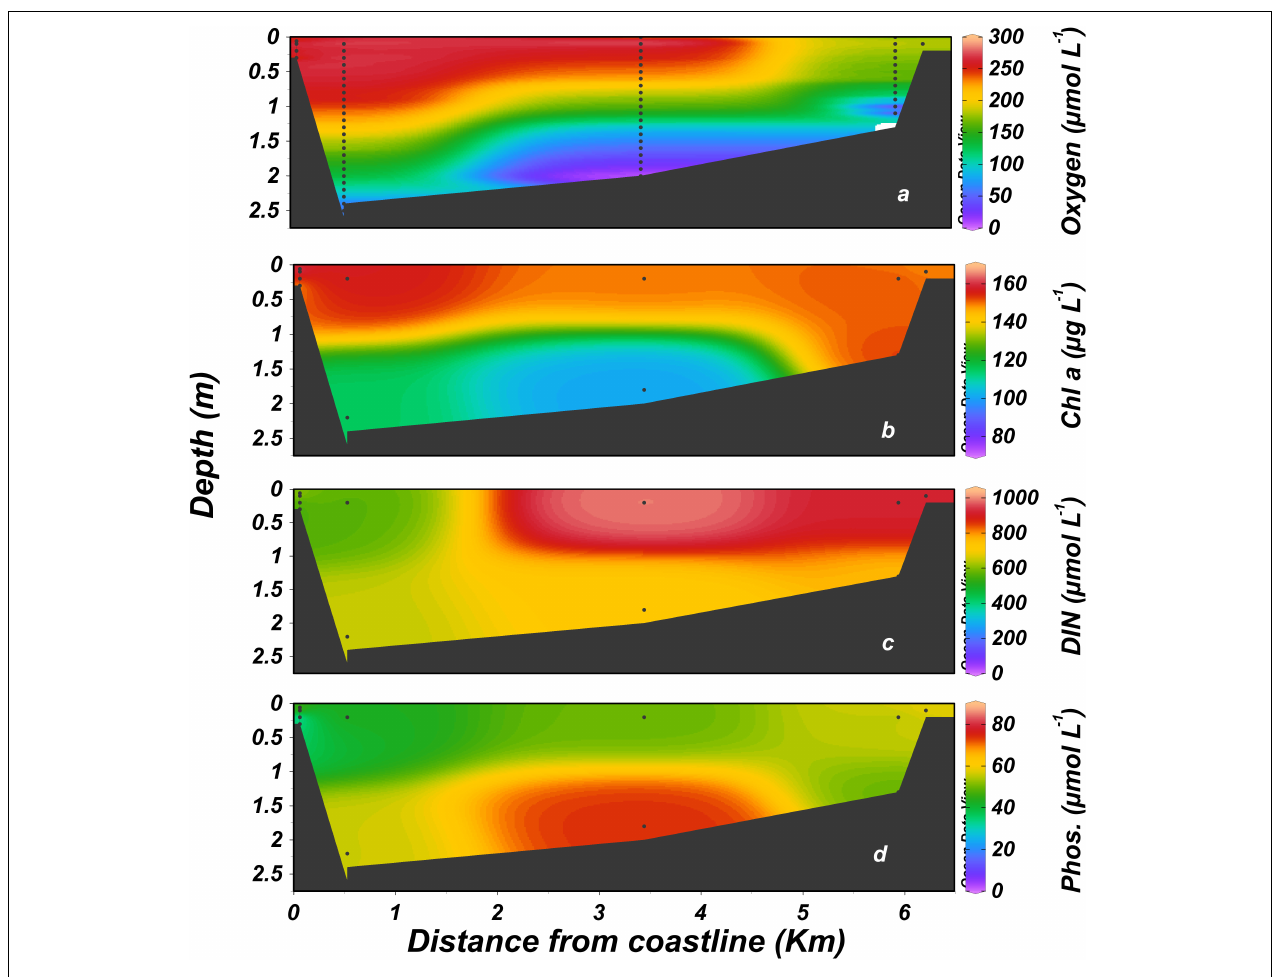
FIGURE 5 | Distribution of dissolved nutrients, dissolved oxygen and chlorophyll a along the Alexander estuary. January 2014 to August 2016. (a) Dissolved oxygen, (b) chlorophyll a , (c) dissolved inorganic nitrogen (DIN, calculated as NO 3 +NO 2 +NH 4 ), (d) phosphate. Black dots represent sampling locations.